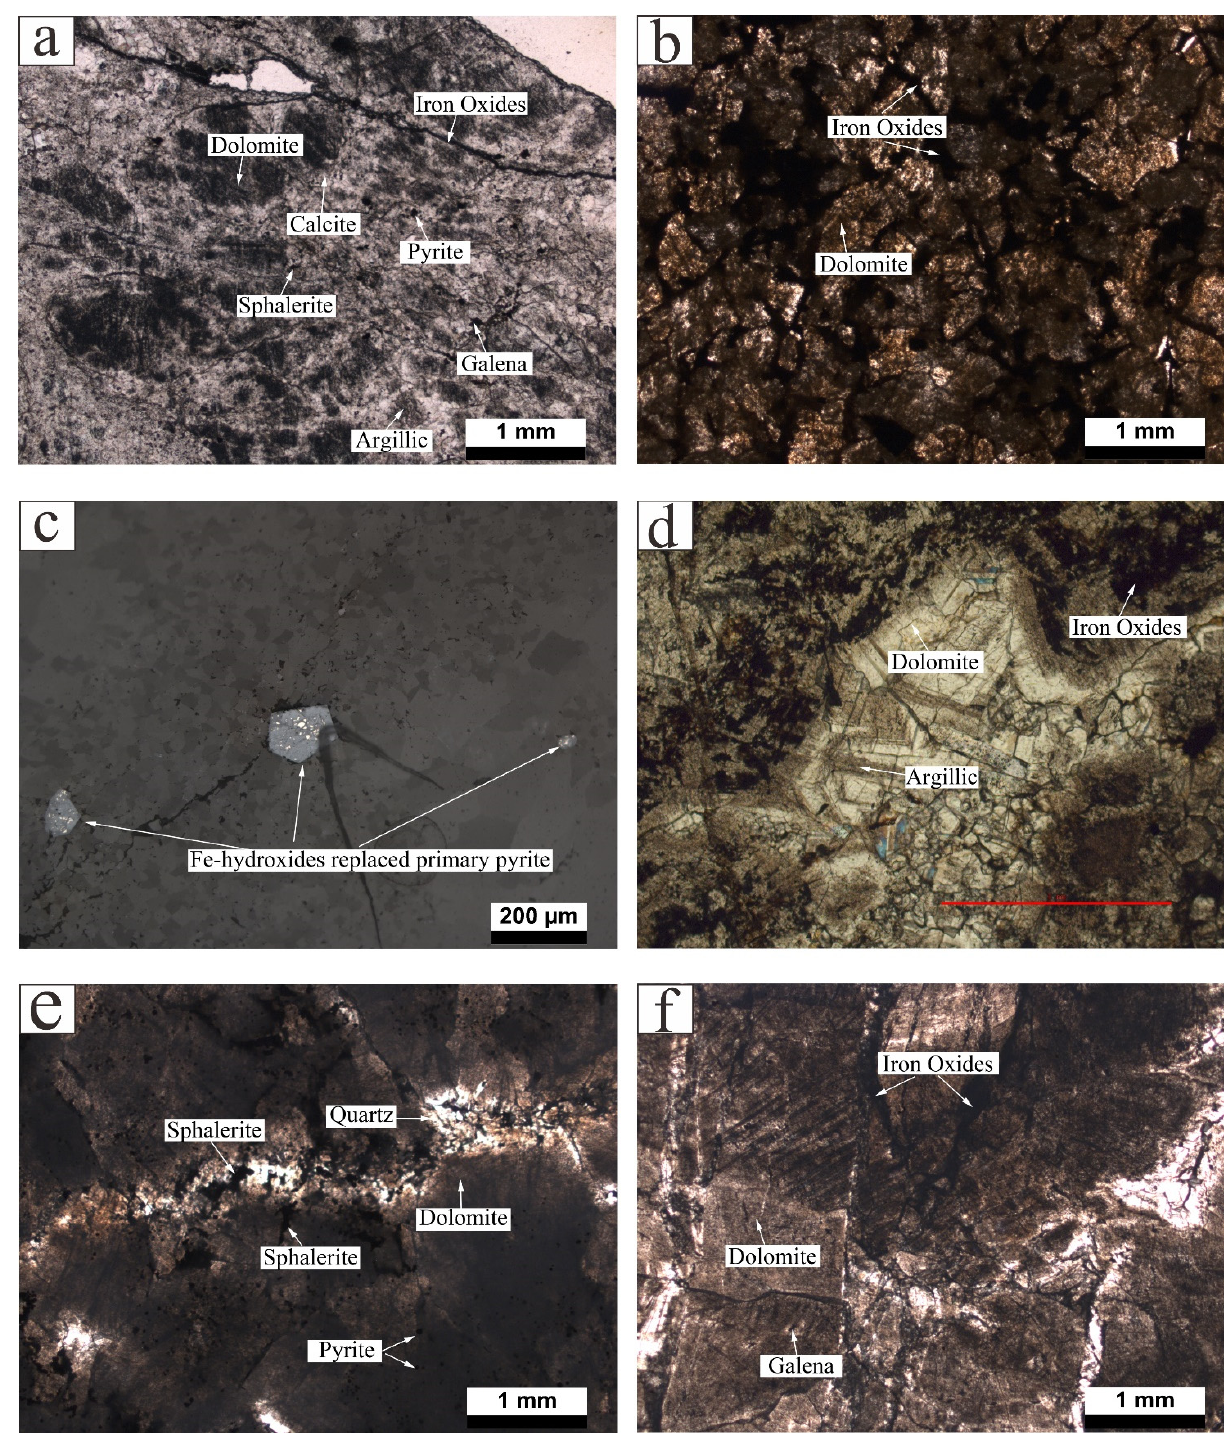
Figure 10. Petrographic study of hydrothermally altered minerals under a microscope. ( a ) The association of iron oxide with argillic, dolomite, calcite, pyrite, galena, and sphalerite; ( b ) dolomite contains iron oxides concentrated in micro-fractures; ( c ) Fe-hydroxides replaced primary pyrite; ( D ) association of iron oxide with argillic and dolomite; ( e ) the association of dolomite with pyrite and sphalerite; ( f ) the association of iron oxide with dolomite and galena.